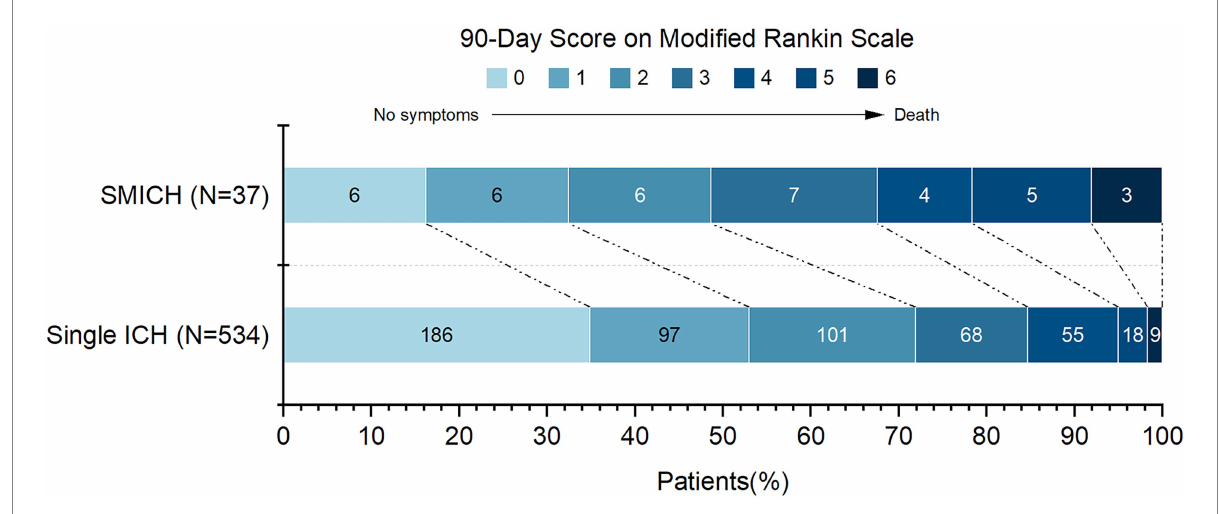
FIGURE 3 90-Day functional outcomes (modified Rankin Scale score) among patients grouped by simultaneous multiple intracerebral